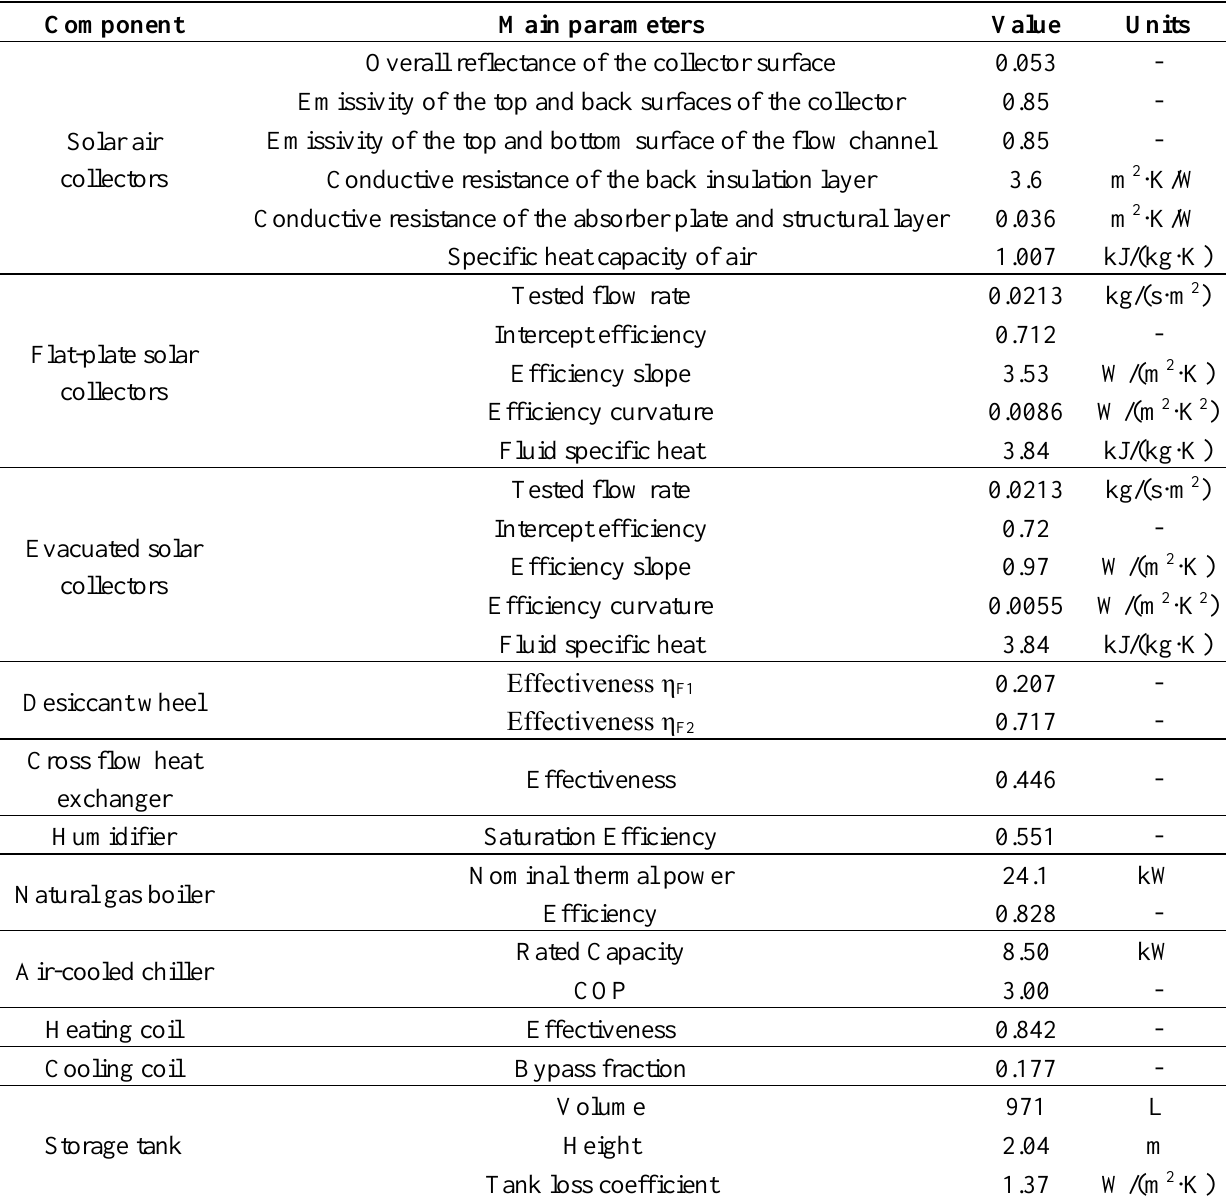
Table 1. Models used for solar collectors simulation and their main